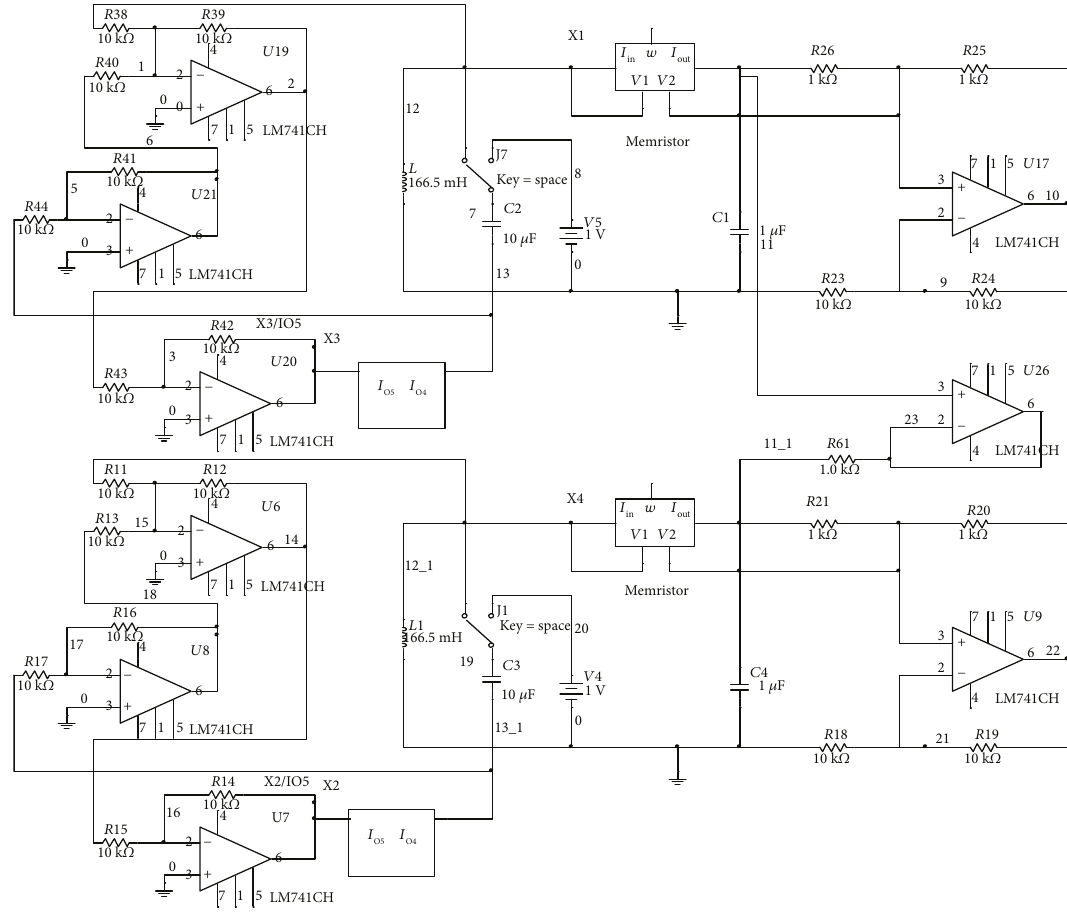
Figure 17: Drive-response synchronous circuit of the multiscroll hyperchaotic system.